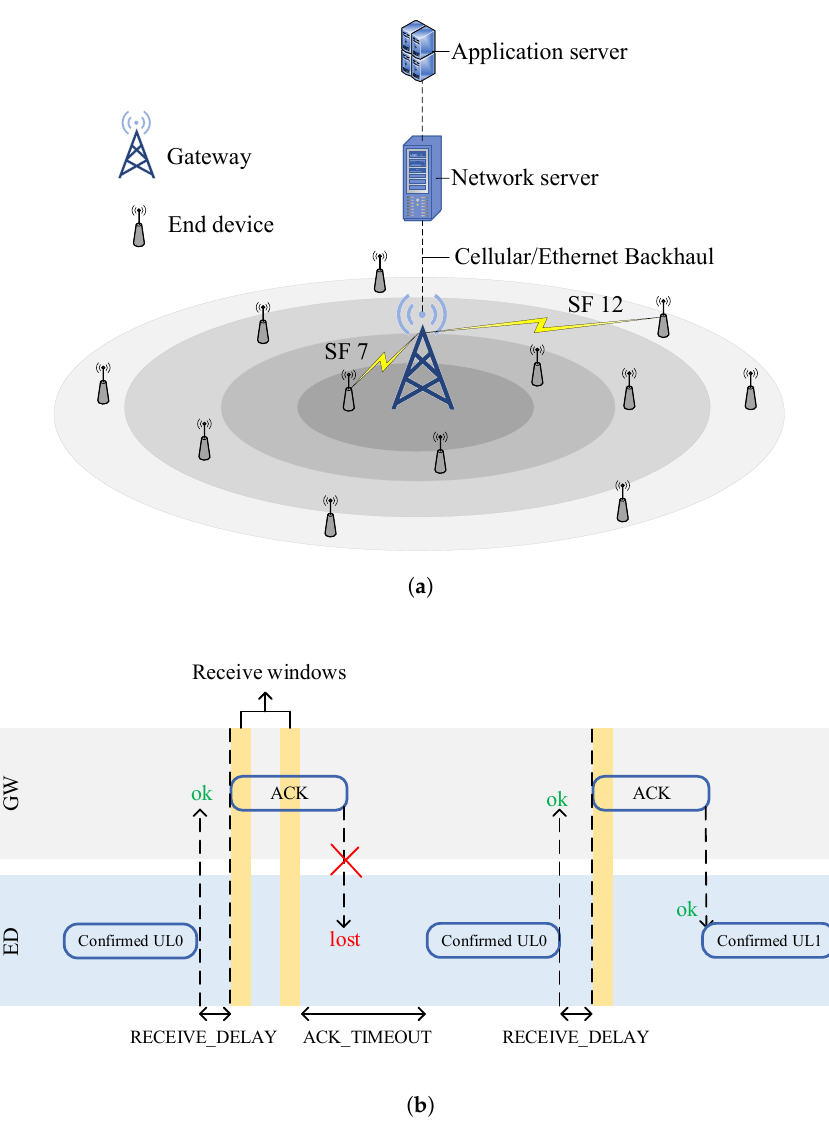
Figure 1. A brief working of long-range wide area network (LoRaWAN): ( a ) underlying architecture comprised of end devices (EDs), gateway (GW), network server (NS), and application server, and ( b ) transmission procedure in confirmed